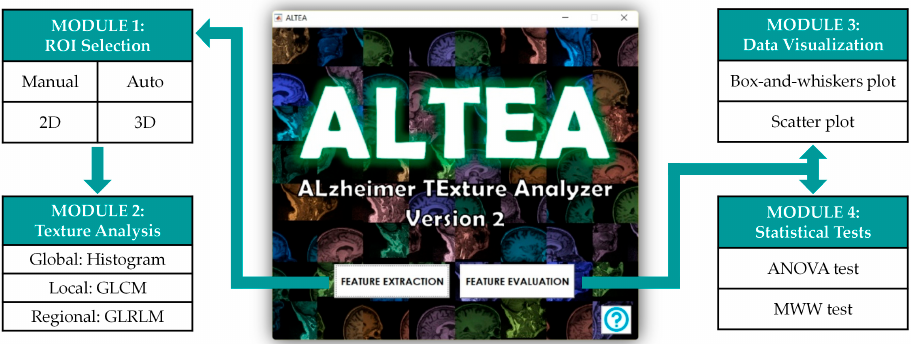
Figure 2. Structure of the software tool ALTEA (ALzheimer TExture Analyzer) designed for the purpose of this study. The tool has two main blocks, “Feature Extraction” and “Feature Evaluation”, and each block has two sub-blocks or modules, as shown in the image.